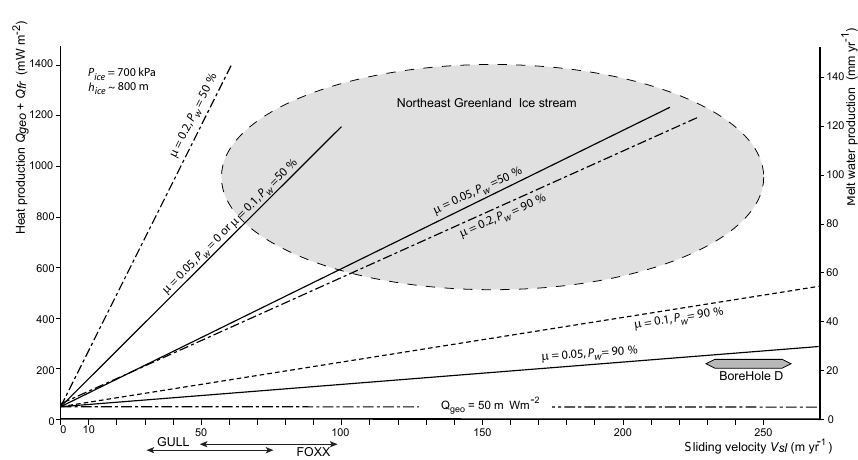
Figure 1. Basal heat production (left) caused by geothermal heat flux and frictional heating as a function of basal sliding velocity, for different values of friction coefficient µ and water pressure P w as a percentage of overburden pressure. Geothermal heat flow taken at 50mWm − 2 . On the right-hand side the rate of meltwater production, assuming all heat is taken up by melting. Sliding velocities of Borehole D (adjacent to Jakobshavn Isbræ) after Lüthi et al. (2002); melt rate calculated on basis of thermal gradient, using Eq. (1). Sliding velocities and basal melt production of Northeast Greenland Ice stream after Joughin et al. (2001) and Fahnestock et al. (2001). GULL and FOXX show seasonal range of basal ice velocities deduced from borehole data near Swiss Camp, West Greenland (Ryser et al., 2014).